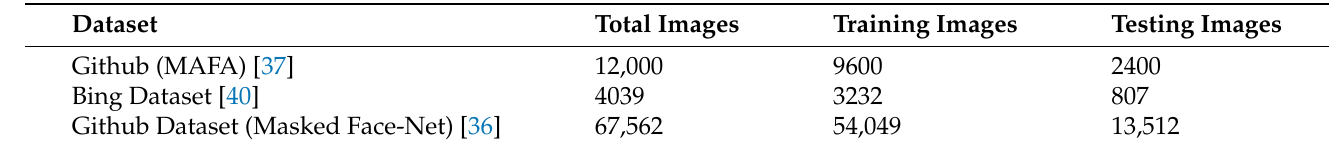
Table 2. Datasets Description.